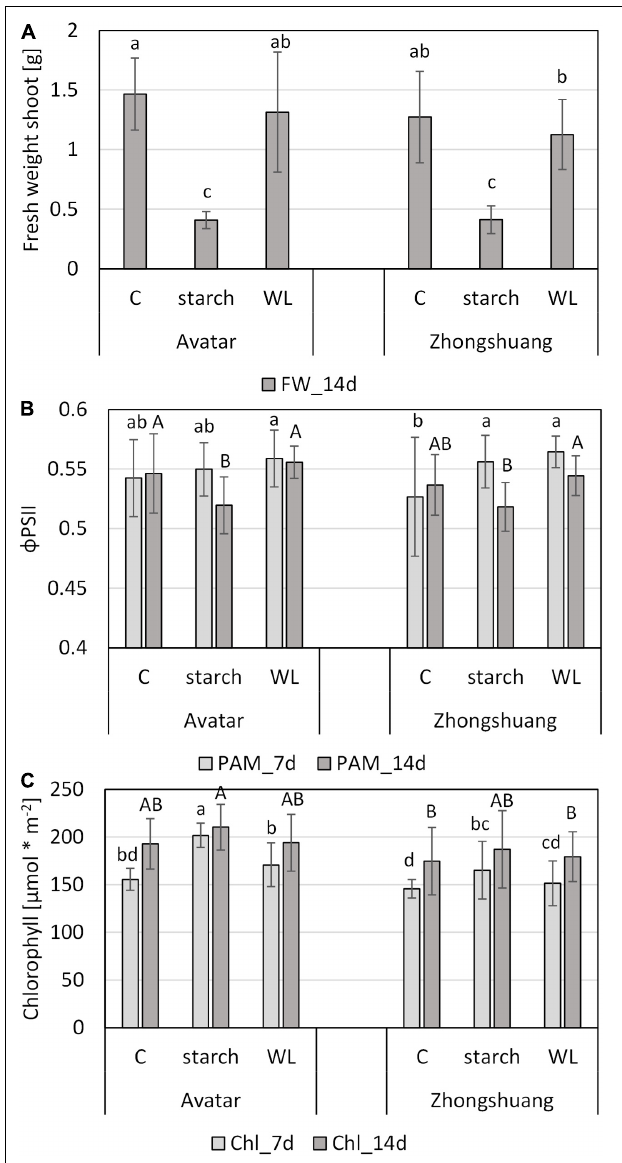
FIGURE 7 | Performance of two Brassica napus cultivars (Avatar, Zhongshuang 9) on soil under waterlogging with a 0.1% starch solution (“starch”) or with distilled water (“WL”) for up to 14 days. At time of harvest, plants were 29 days old. (A) Fresh weight of shoots after 14 days of stress treatment compared with controls. (B) Chlorophyll fluorescence ( (cid:56) PSII) after 7 and 14 days of stress treatment compared with controls. (C) Chlorophyll content [ µ mol ∗ m − 2 ] in leaves of after 7 and 14 days of stress. Data are means ± SD of 3 experiments with 6 plants per experiment ( n = 18). Different letters indicate significant differences (ANOVA and Tukey post hoc test, p <